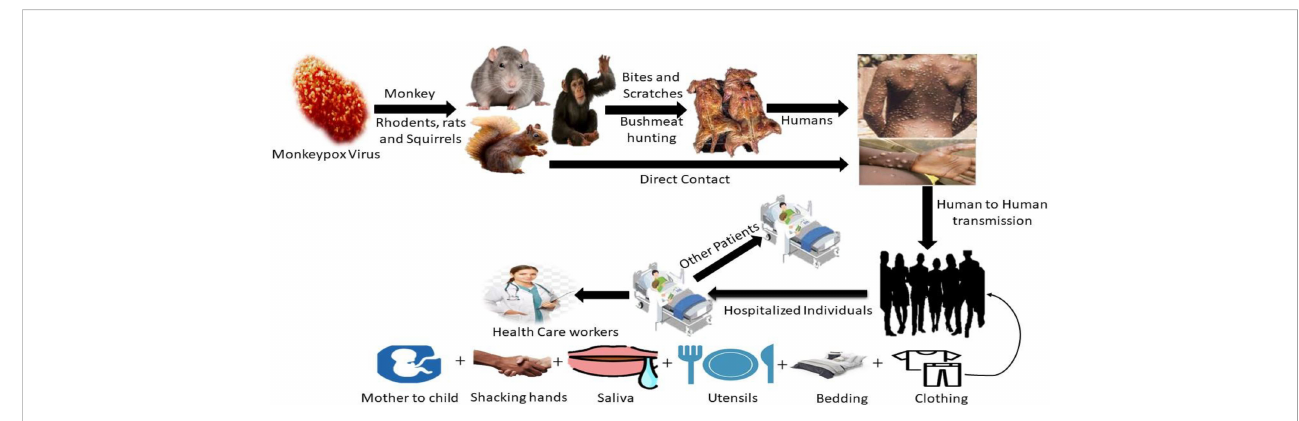
FIGURE 3 The primary host and transmission route of MPX, eating infected animals as a food source, is the major cause of animal-to-human virus transmission. Healthy people can contract the virus by intimately contacting someone who is